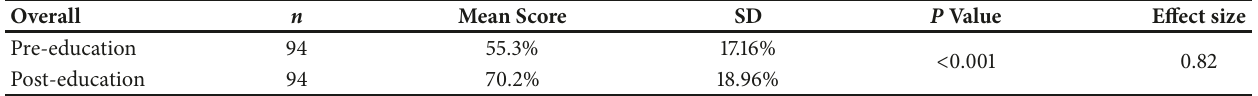
Table 3: Changes in mean score between pre- and posteducation questionnaire.